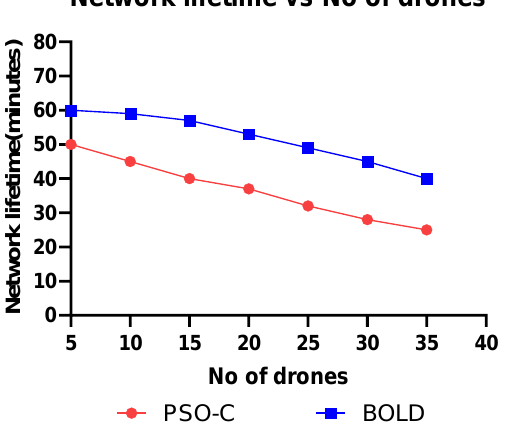
Figure 14. Number of alive drones vs iterations.